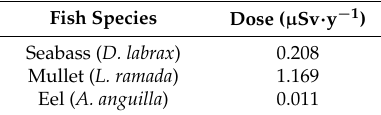
Table 2. Annual dose due to consumption of fish species contaminated by 210 Po.